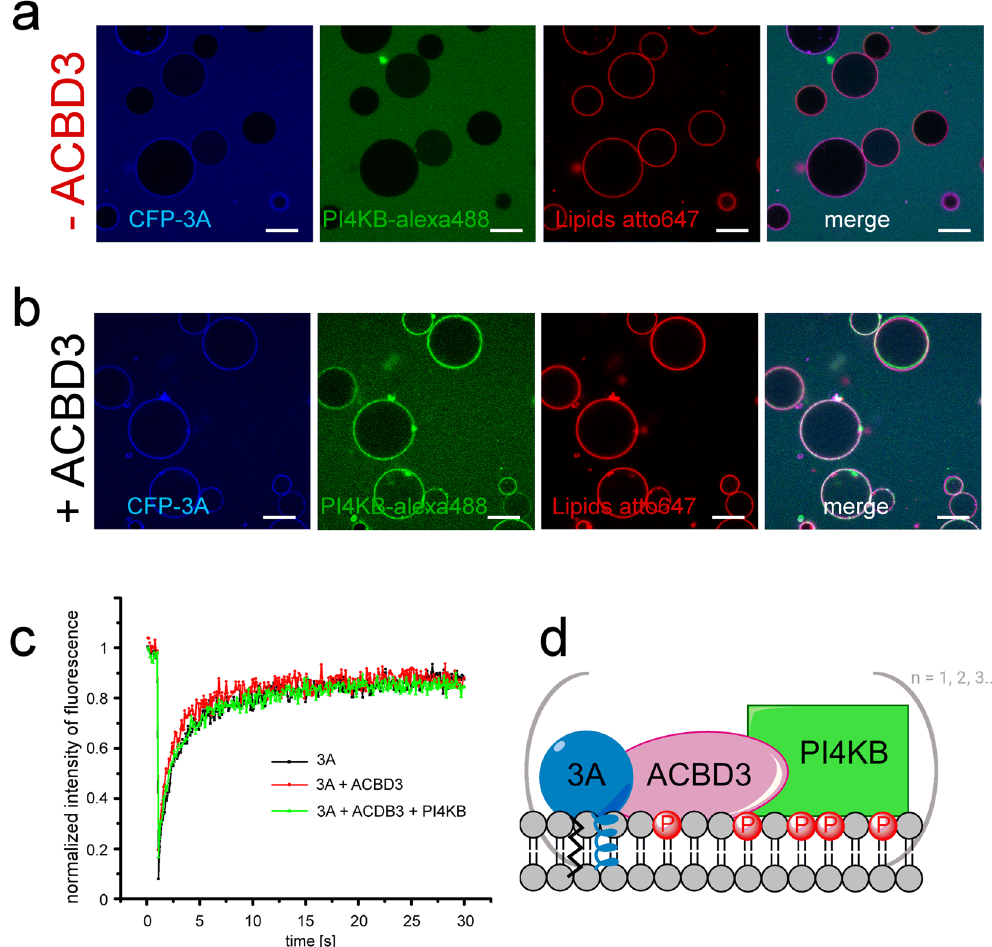
Figure 2. Aichi virus 3A protein recruits the PI4KB kinase via ACBD3. ( A ) 3A protein does not recruit PI4KB directly to GUVs. 250 nM CFP-3A and PI4KB labeled by Alexa488 were added to GUVs containing 5% of DGS-NTA(Ni) and ATTO647N-DOPE (0.1 mol %). The CFP-3A signal is in blue, the PI4KB-Alexa488 signal is in green and the ATTO647 signal is in red. Representative image of three independent experiments. Scale bar = 20 µ m. ( B ) PI4KB is recruited to membranes when ACBD3 is present. CFP-3A, Alexa488 labeled PI4KB and unlabeled ACBD3 (250 nM each) were added to GUVs containing 5% DGS-NTA(Ni) and ATTO647N- DOPE (0.1 mol %). The CFP-3A signal is in blue, the PI4KB-Alexa488 signal in green and the ATTO647 signal is in red. Representative image of three independent experiments. Scale bar = 20 µ m. ( C ) FRAP analysis of the 3A:ACBD3:PI4KB protein complex. A small cross-section of a GUV membrane was intensively bleached by a 405 nm laser and fluorescence recovery after photobleaching (FRAP) of CFP-3A was measured. ( D ) Schematic representation of the 3A:ACBD3:PI4KB protein